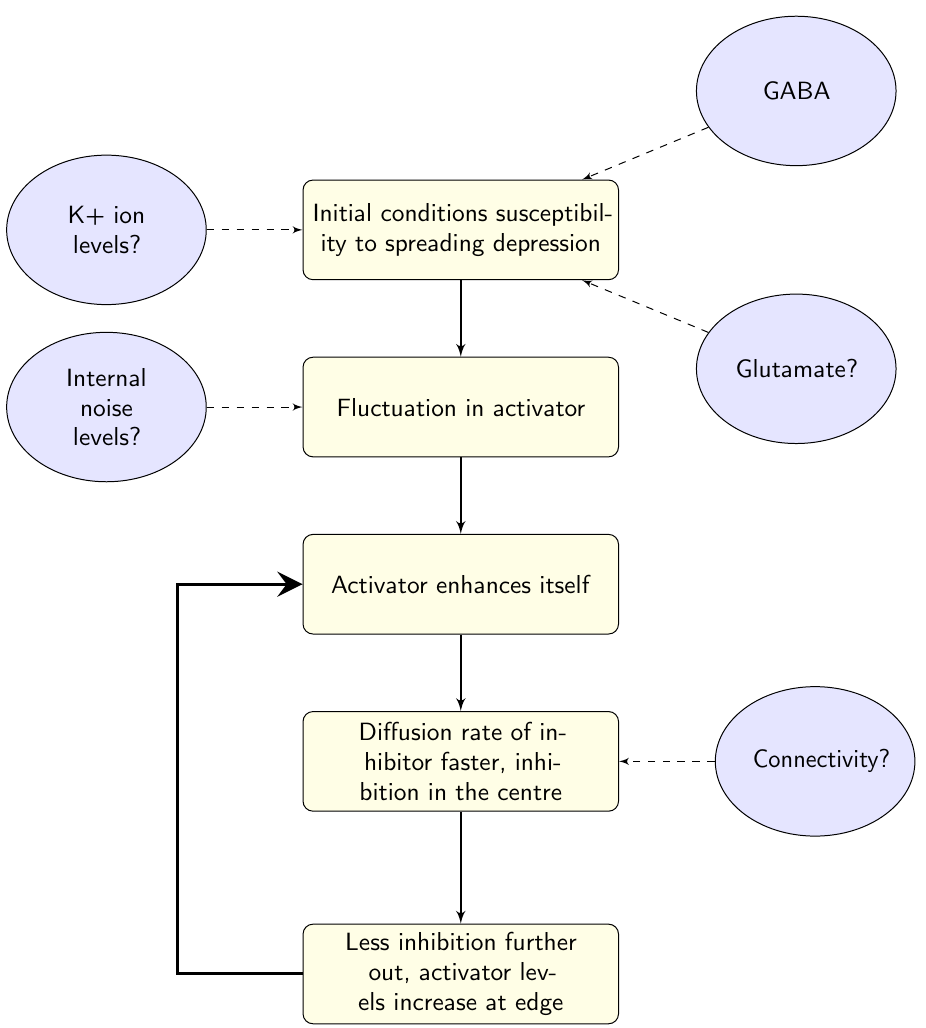
Figure 8. A schematic diagram of the main model stages and the possible parameters that have been associated with spreading depression. The initial conditions (prior to the initiating event) represent the susceptibility of the cortex to spreading depolarisation and subsequent depression. This could be due to neurotransmitters such as GABA, glutamate, and K+ ion levels. The next stage is the precipitating event, represented in the model by random fluctuation in activity. It is possible that random fluctuation is more likely in those with migraine due to increased internal noise in the brain. The next stage of the model is the self-enhancement of the activator. One of the key points for pattern formation is the ratio of diffusion rates for the activator and the inhibitor, which feasibly relate to the coupling strength or connectivity within the